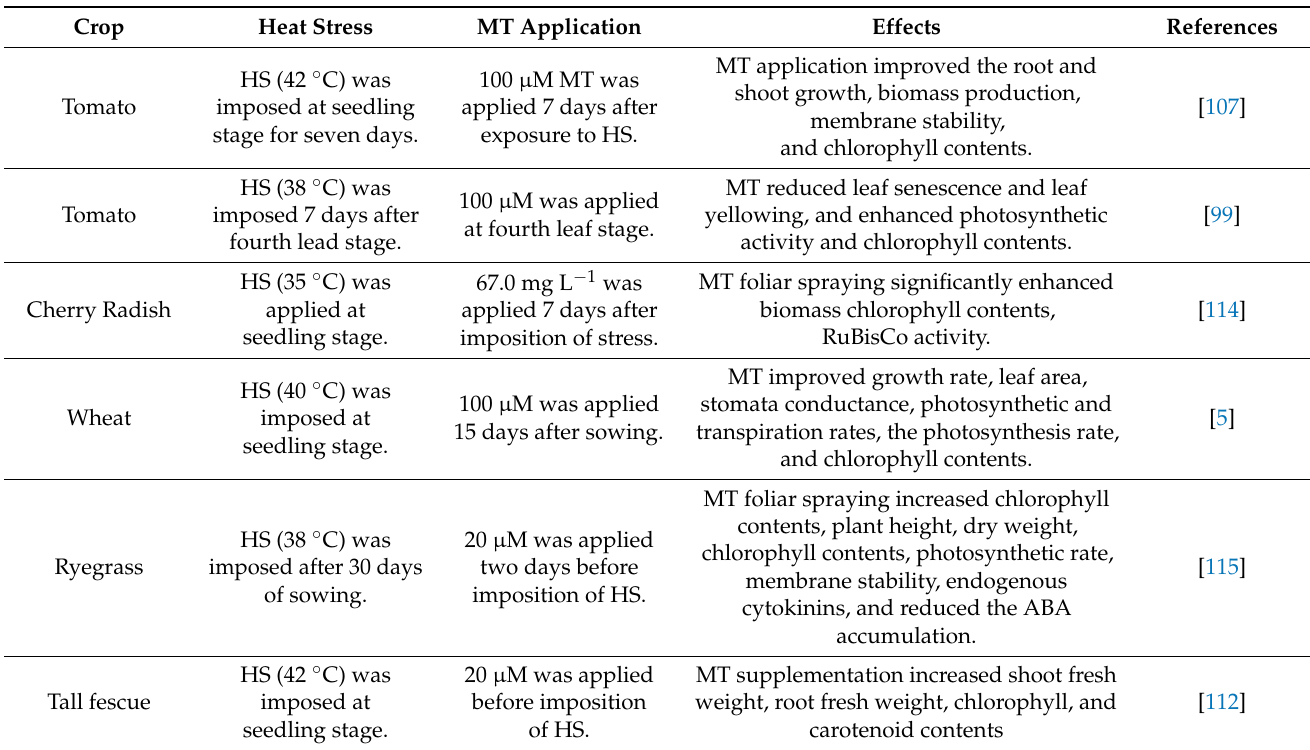
Table 2. Effect of melatonin on growth and physiological attributes under heat